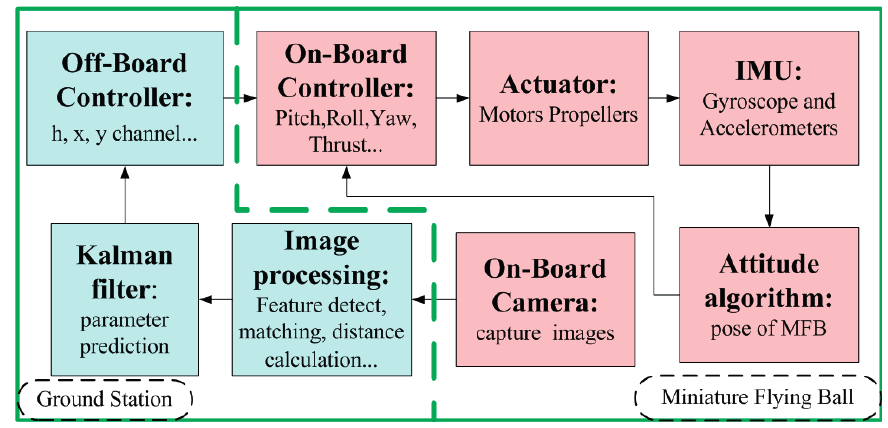
Figure 6. System